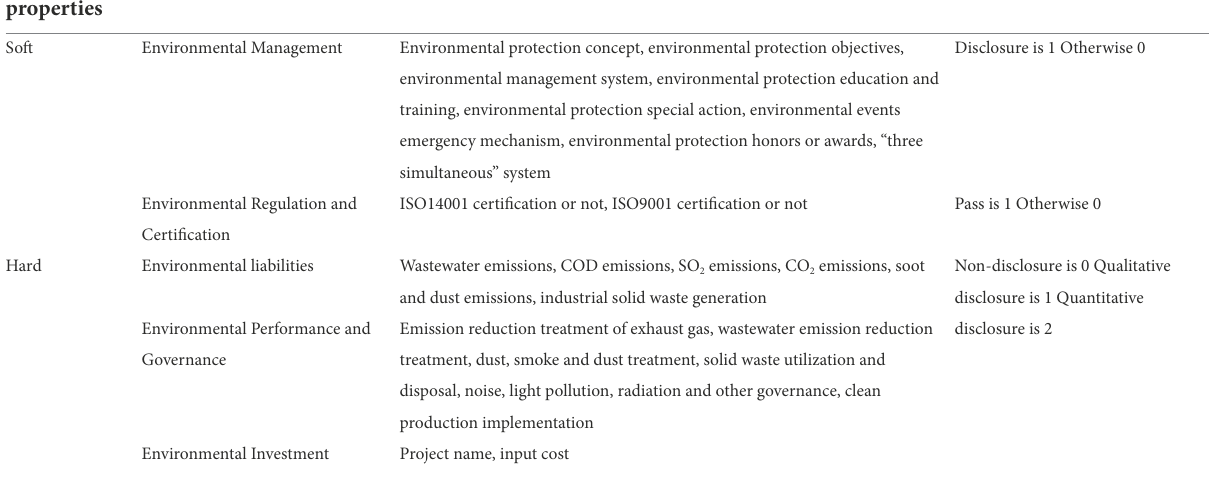
TABLE 1 EID quality index